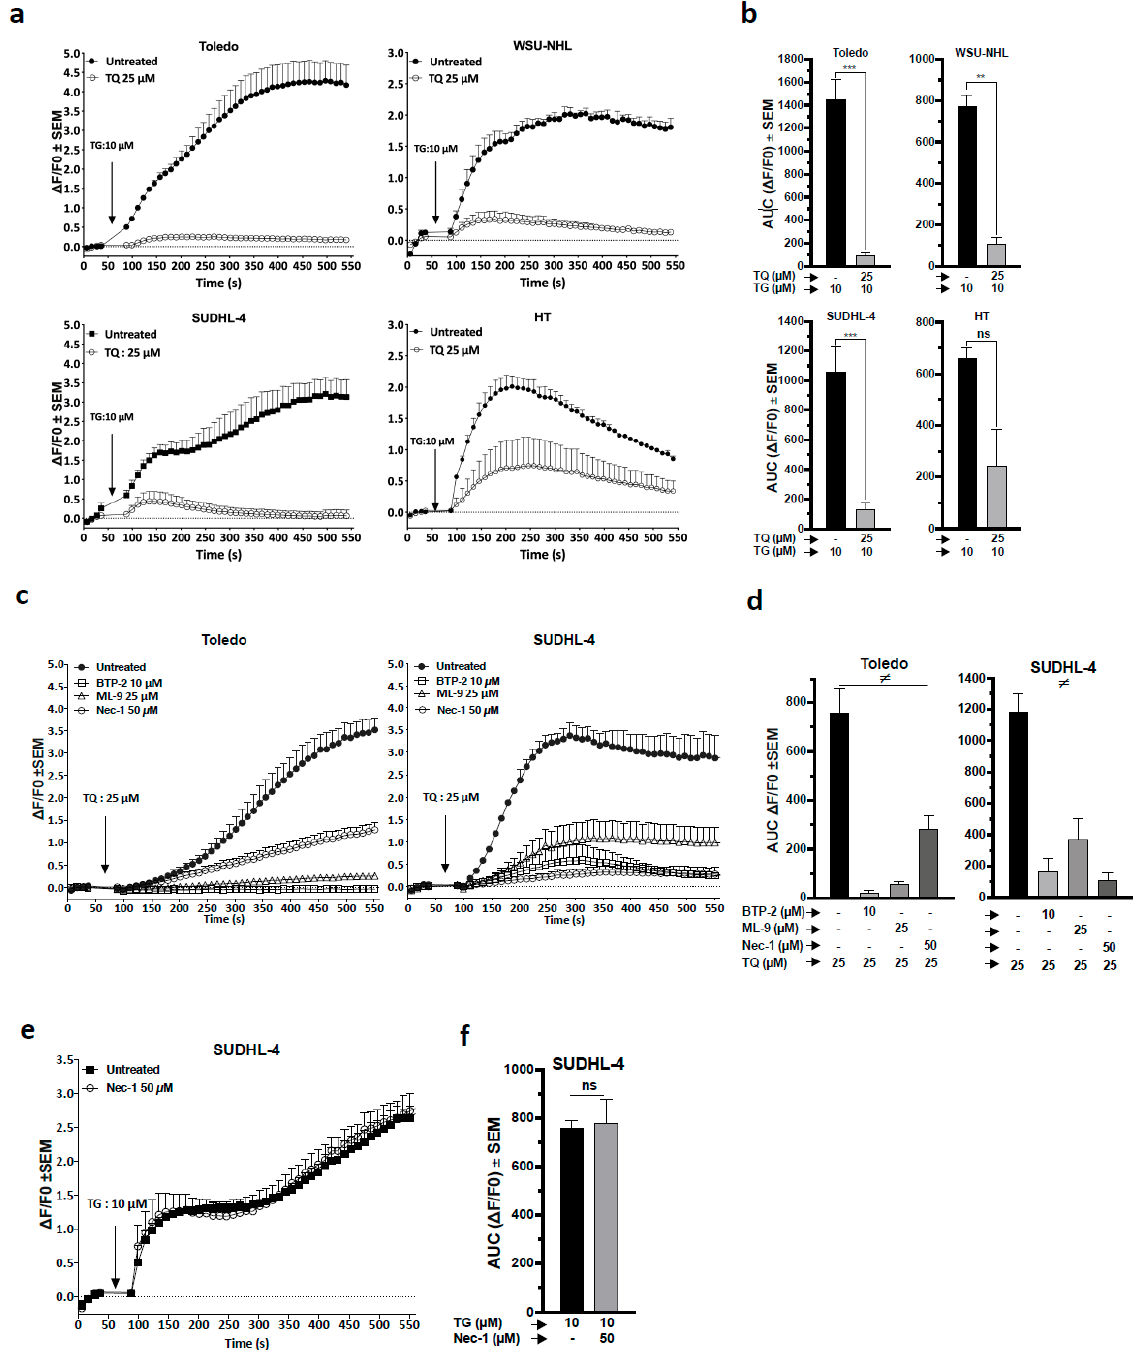
Figure 5. Role of ER-calcium depletion and necroptosis in TQ-mediated calcium efflux. ( a – f ) Cells were pretreated as indicated for 1 h, then cytosolic calcium was continuously monitored via flow cytometry in the presence of the indicated drug added at 60 s. For all experiments, the curve represents the peak intensity of the fluorescence at 10 s intervals, and the corresponding area under the curve (AUC) was calculated. ( a ) Effect of TQ on TG-induced ER calcium release in cell lines: the cells were pretreated with 25 µM TQ or DMSO for 1 h, then cytosolic calcium was analyzed in the presence of 10 µM TG. ( b ) AUC calculated from the calcium response curves in A. ( c ) Cytosolic calcium mobilization induced by TQ in Toledo and SUDHL-4 cells pretreated with SOCE inhibitors (BTP-2 and ML-9) or an RIPK1 inhibitor (nec-1), and the respective AUCs are shown in ( d ). ( e ) Cytosolic calcium mobilization induced by TG in SUDHL-4 cells pretreated with nec-1, and the corresponding AUC is shown in ( f ). Student’s t -test: ns p > 0.05, * p < 0.05, ** p < 0.01, *** p < 0.001; ANOVA: (cid:54) = p < 0.05; all experiments were repeated at least three